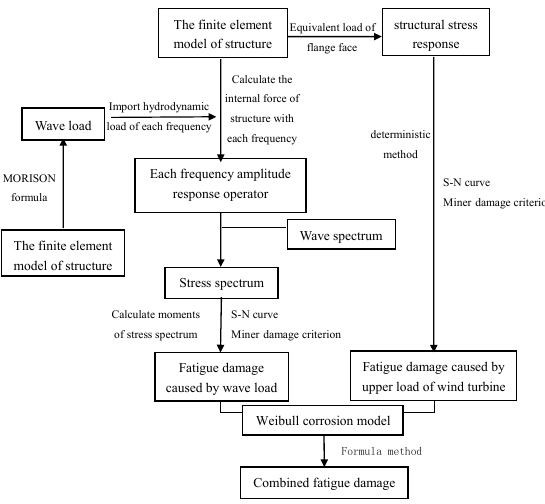
Figure 2. Fatigue analysis procedures of the OWT substructure.